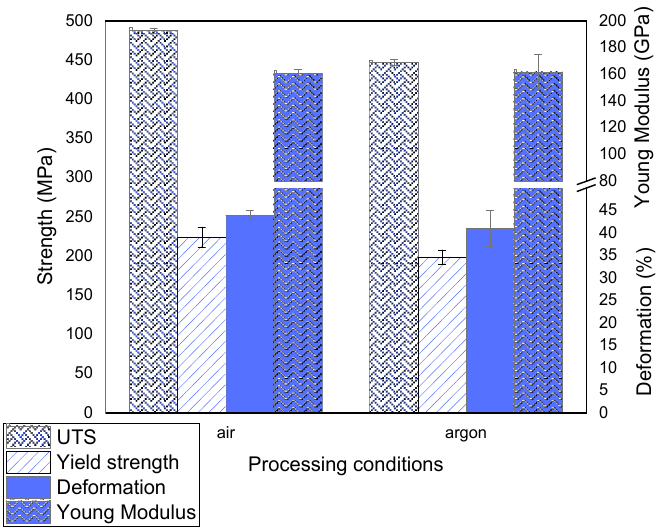
Figure 10. Mechanical properties of PMD as-built specimens vs. the processing conditions of air and argon.